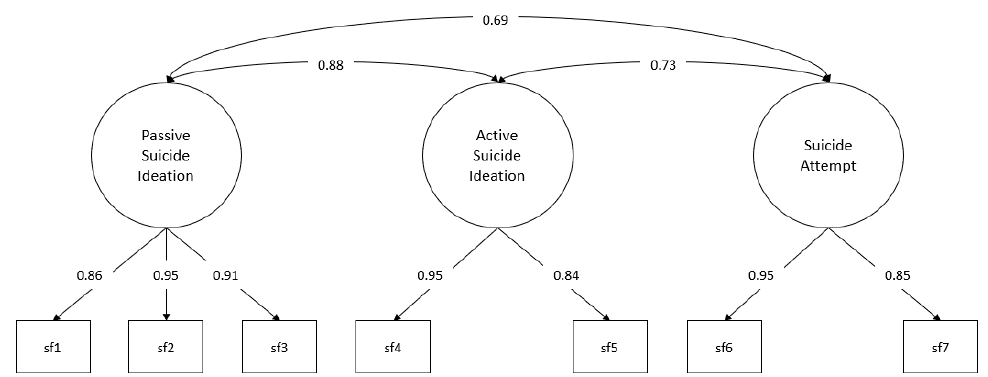
Figure 2. Measurement model: frequency. sf1–sf7: suicide severity indicators, items 1 to 7. Standard- ised factor loadings and interfactor correlations.